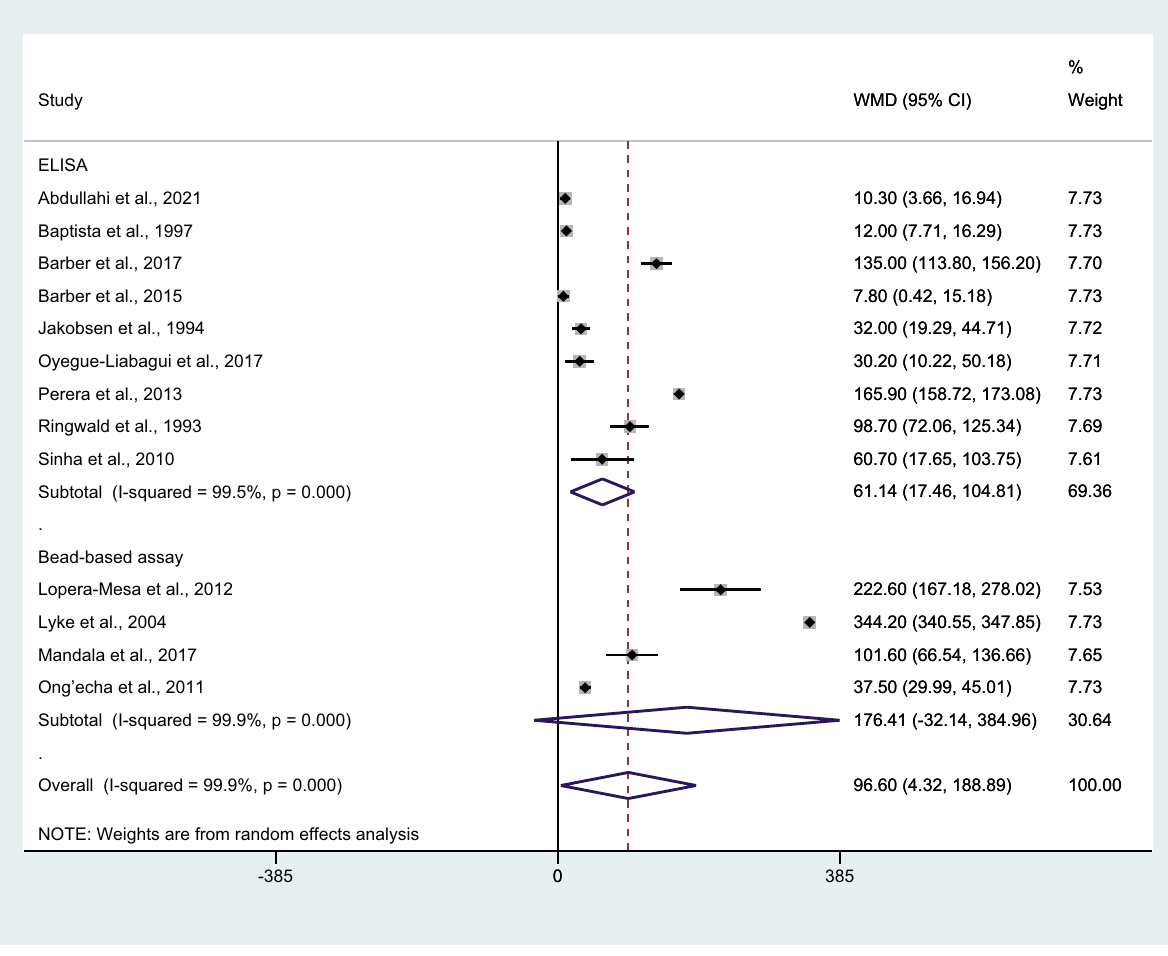
Figure 6. Differences in IL-6 levels between patients with severe malaria and non-severe malaria by assays for IL-6. Abbreviation: WMD, weighted mean difference; CI, confidence interval; black diamond symbol, point estimate; solid line in the middle of the graph at 0, zero effect size; Dashed red line: pooled WMD between the two groups; I 2 , level of heterogeneity; P = 0.000 or less than 0.05, significant